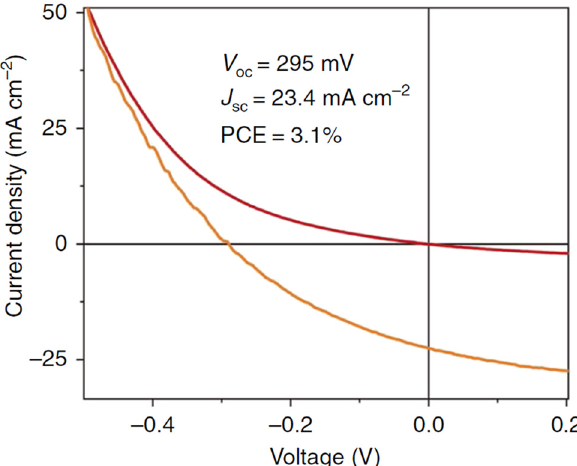
Figure 8: Current – voltage characteristics of the electrodeposited n - type silicon layer on p - type single crystalline silicon wafer under dark and under 100 mW · cm − 2 illumination [ 127 ] . Permission from Springer